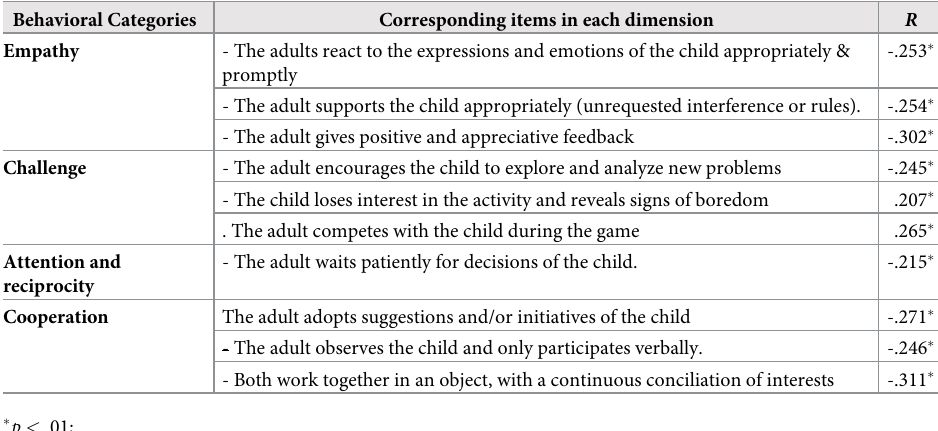
Table 9. Pearson correlations between adult interactive behavior and the adult age (parents and educators). Behavioral